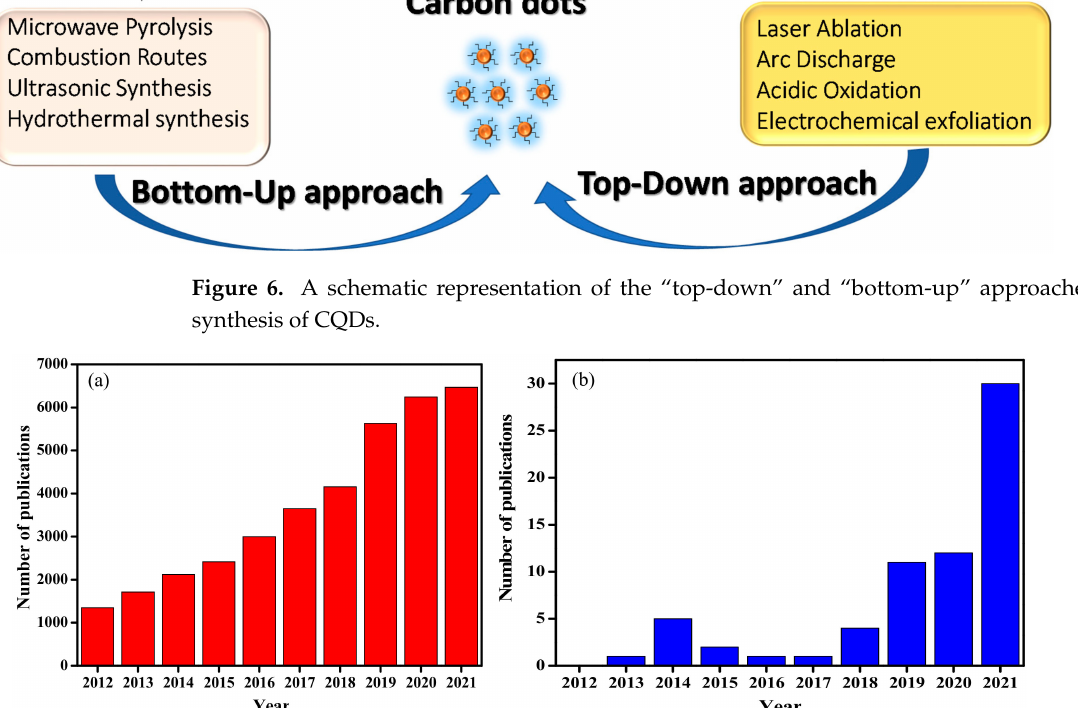
Figure 7. The number of publications containing “carbon dots” from 2012 to 2021 ( a ), and ( b ) the number of publications containing “carbon dots from agricultural waste” from 2012 to 2021. Data obtained from Web of Science in February